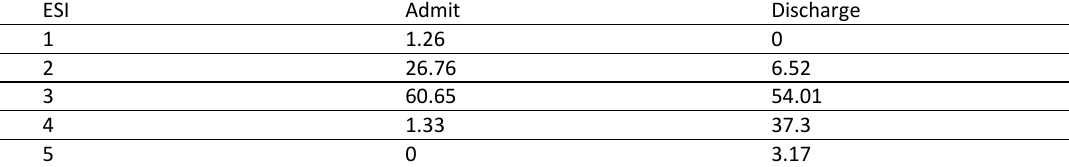
Table 1 The distribution of patients per ESI level for admission or discharge